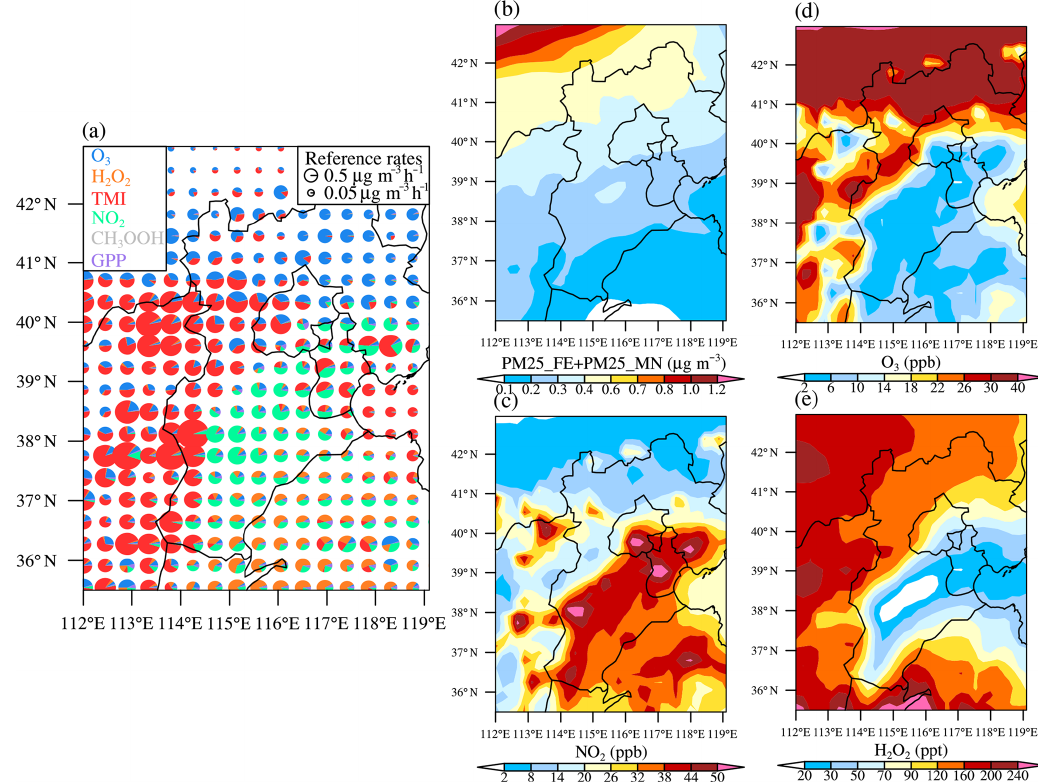
Figure 7. (a) The relative contributions of six sulfate formation pathways, namely aqueous-phase oxidation by dissolved O 3 , H 2 O 2 , TMI (in presence of O 2 ), NO 2 , and CH 3 OOH, as well as gas-particle partitioning of H 2 SO 4 vapor (GPP) at the surface layer simulated in the CTRL scenario during January 2013. The radius R for the pie chart in (a) is scaled using R/R ref = 2exp ( log10 (P/P ref )) , and the reference sulfate production rate P is also shown. Horizontal distribution of the concentrations of (b) the sum of PM25_FE and PM25_MN, (c) NO 2 , (d) O 3 , and (e) H 2 O 2 simulated in the CTRL scenario during January